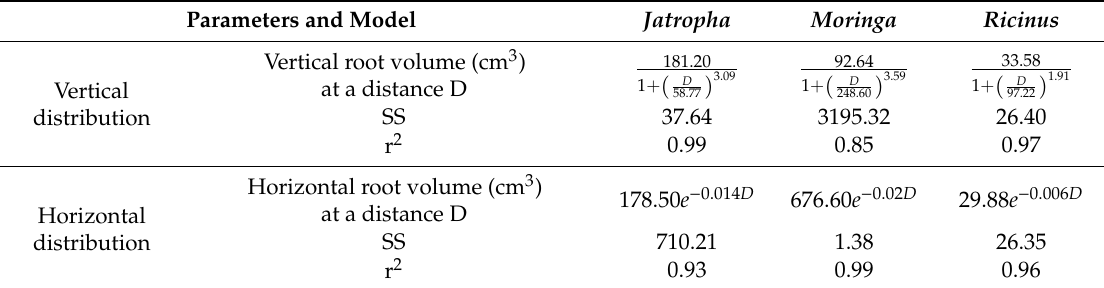
Table 8. Root distribution models of Jatropha curcas , Moringa oleifera , and Ricinus communis 83 days after root pruning and